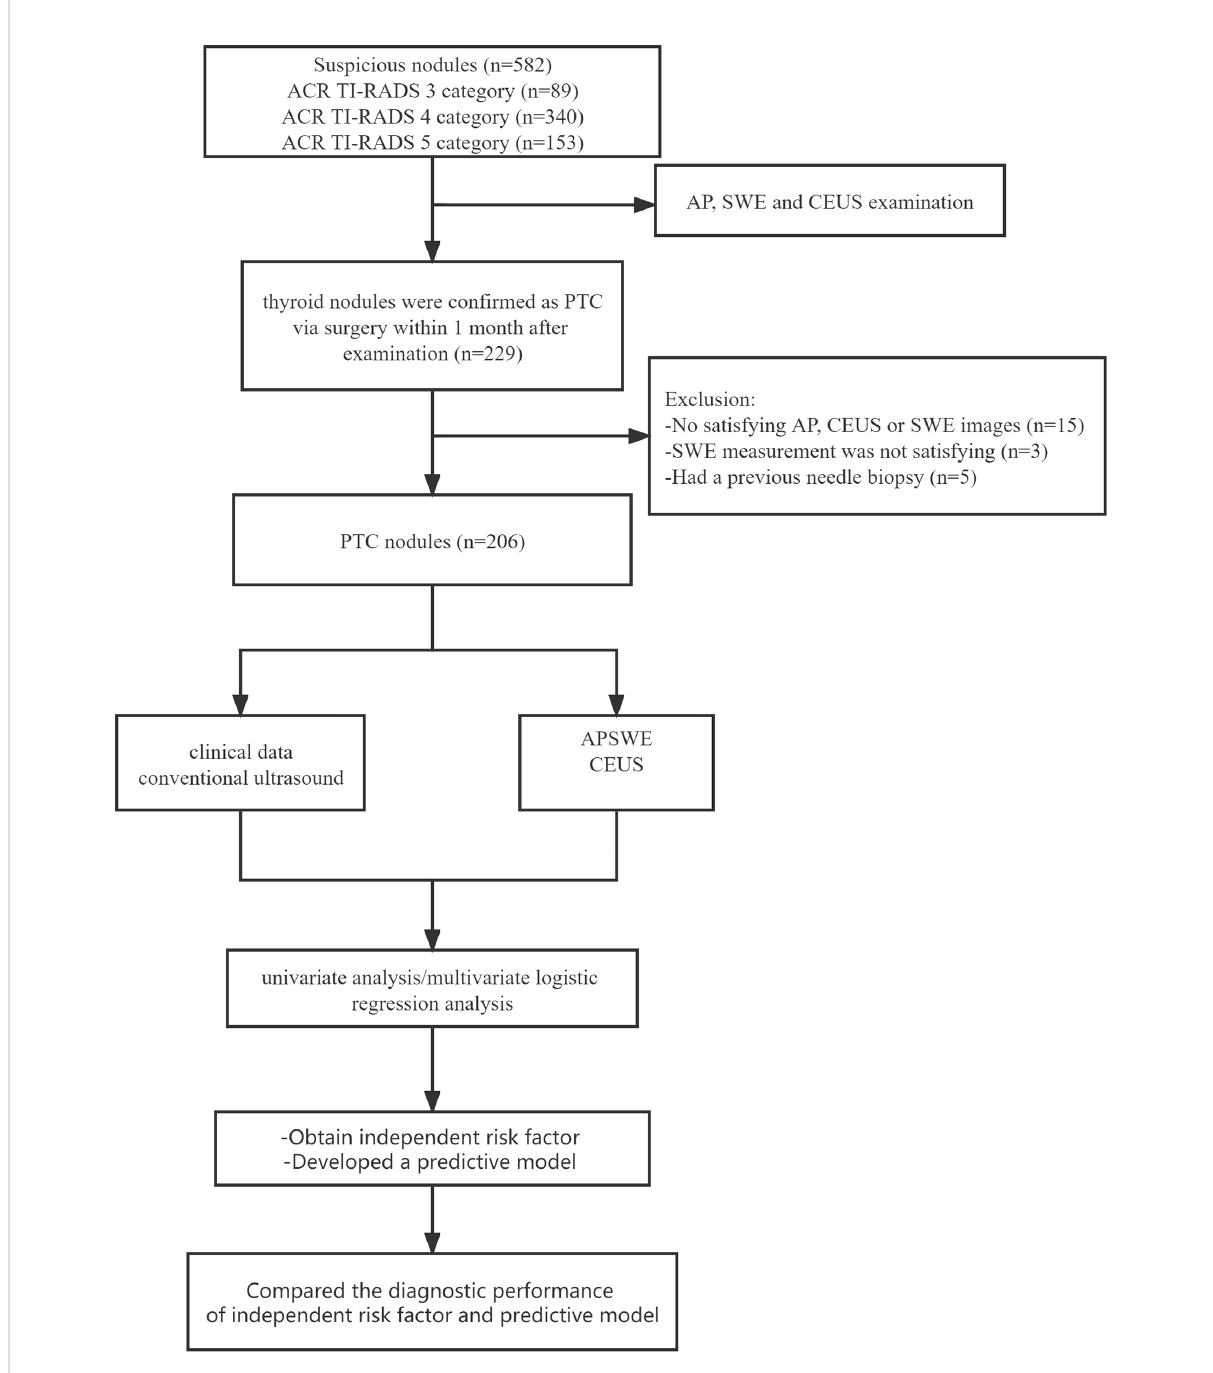
FIGURE 1 The fl owchart of selection of thyroid carcinoma